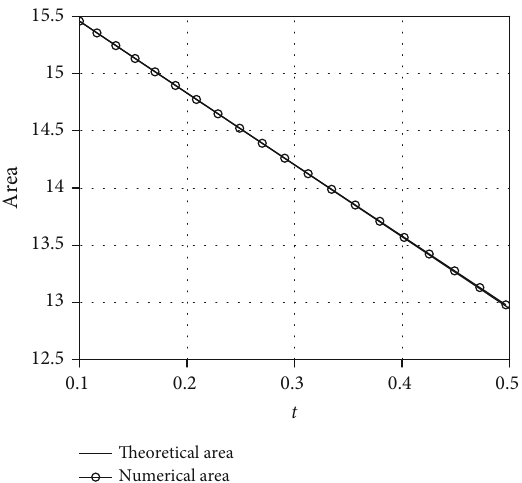
Figure 4: Temporal evolution of the theoretical and numerical areas of zero level set with reference time t